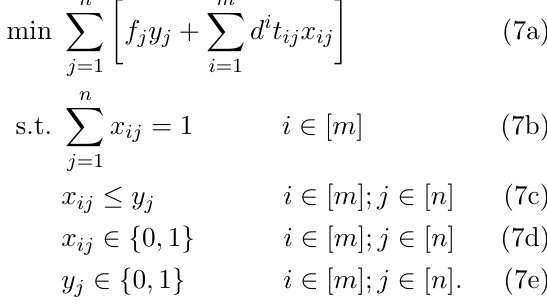
Figure 2. Box plot of the results for the Newsvendor Problem with Binomial(10, 0.5) and R = 100.